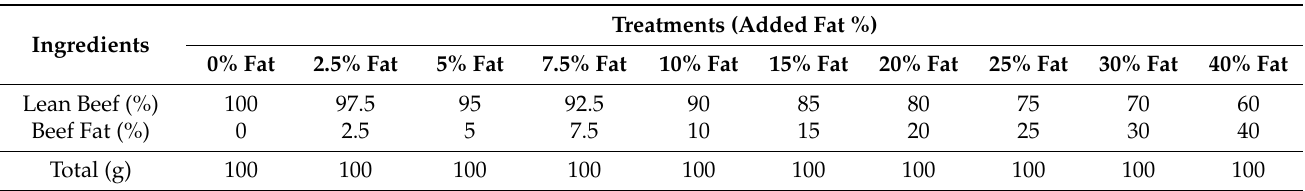
Table 1. Formulation of treatments for Patty 1 (ground burger/ground patty).